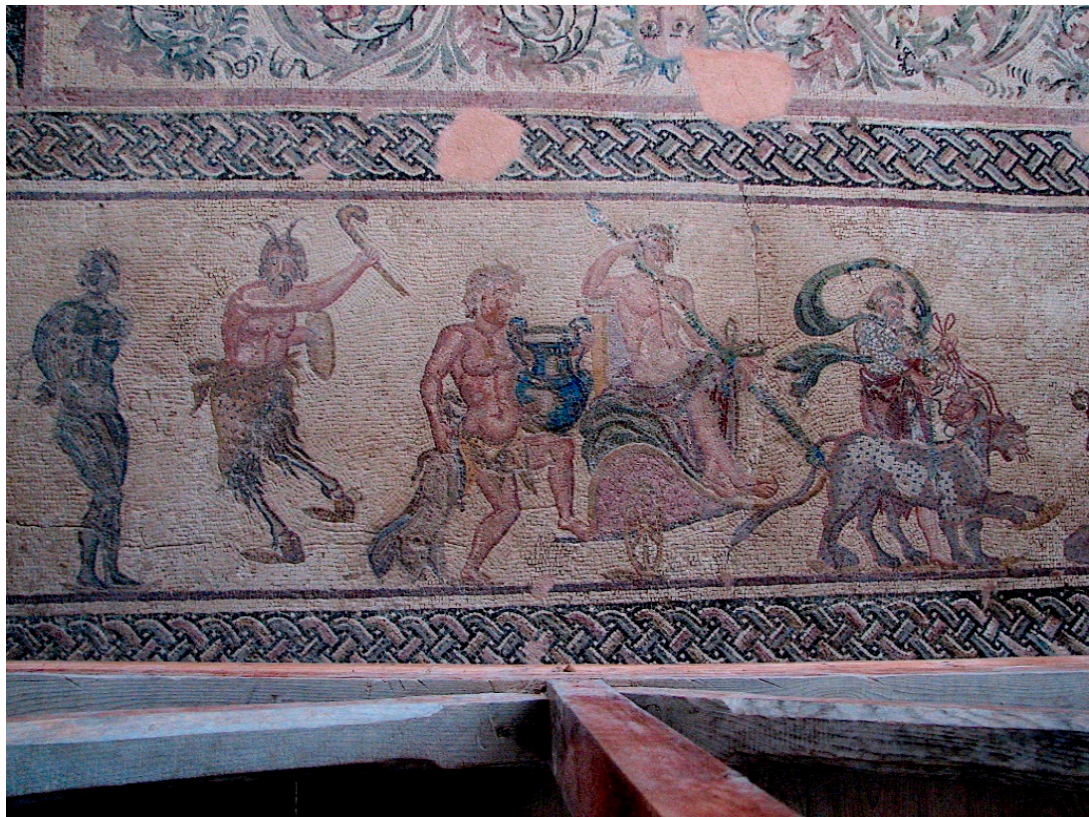
Figure 11. Floor mosaic from the House of Dionysos, Nea Paphos, showing the Triumph of Dionysos. Photo by J.M.